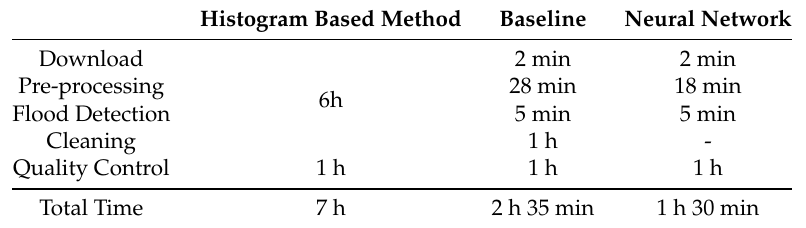
Table 6. Time per activity for the three methodologies investigated during the Cost-Effectiveness